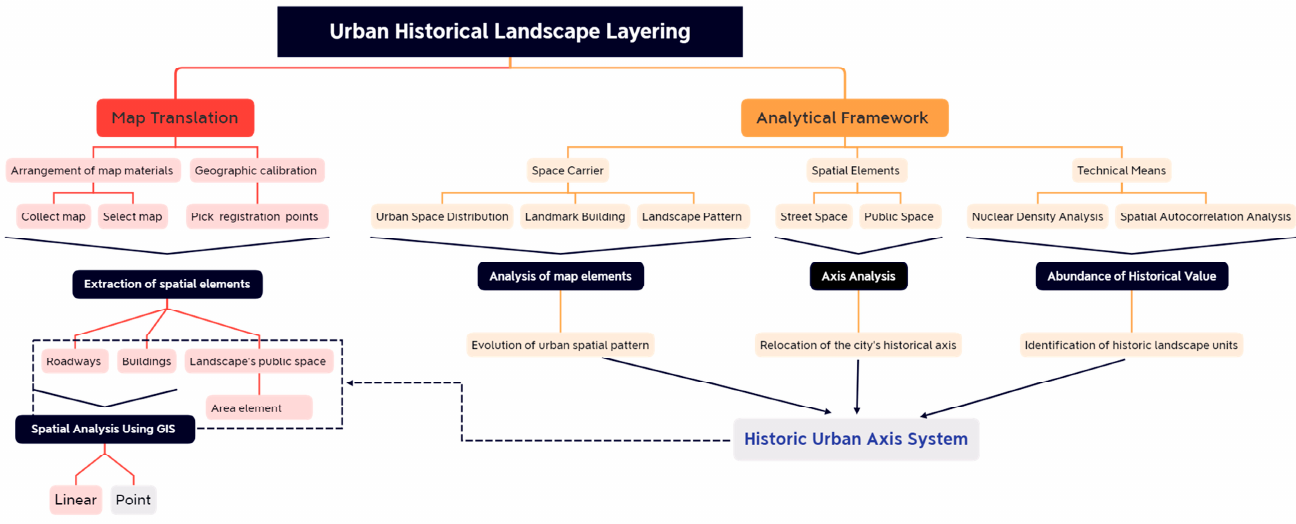
Figure 4. An analytical framework for historical urban landscapes.